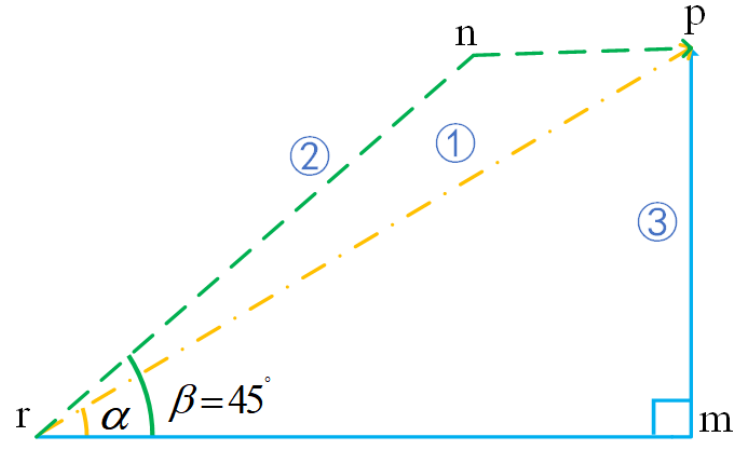
Figure 2. Three types of movement for laser